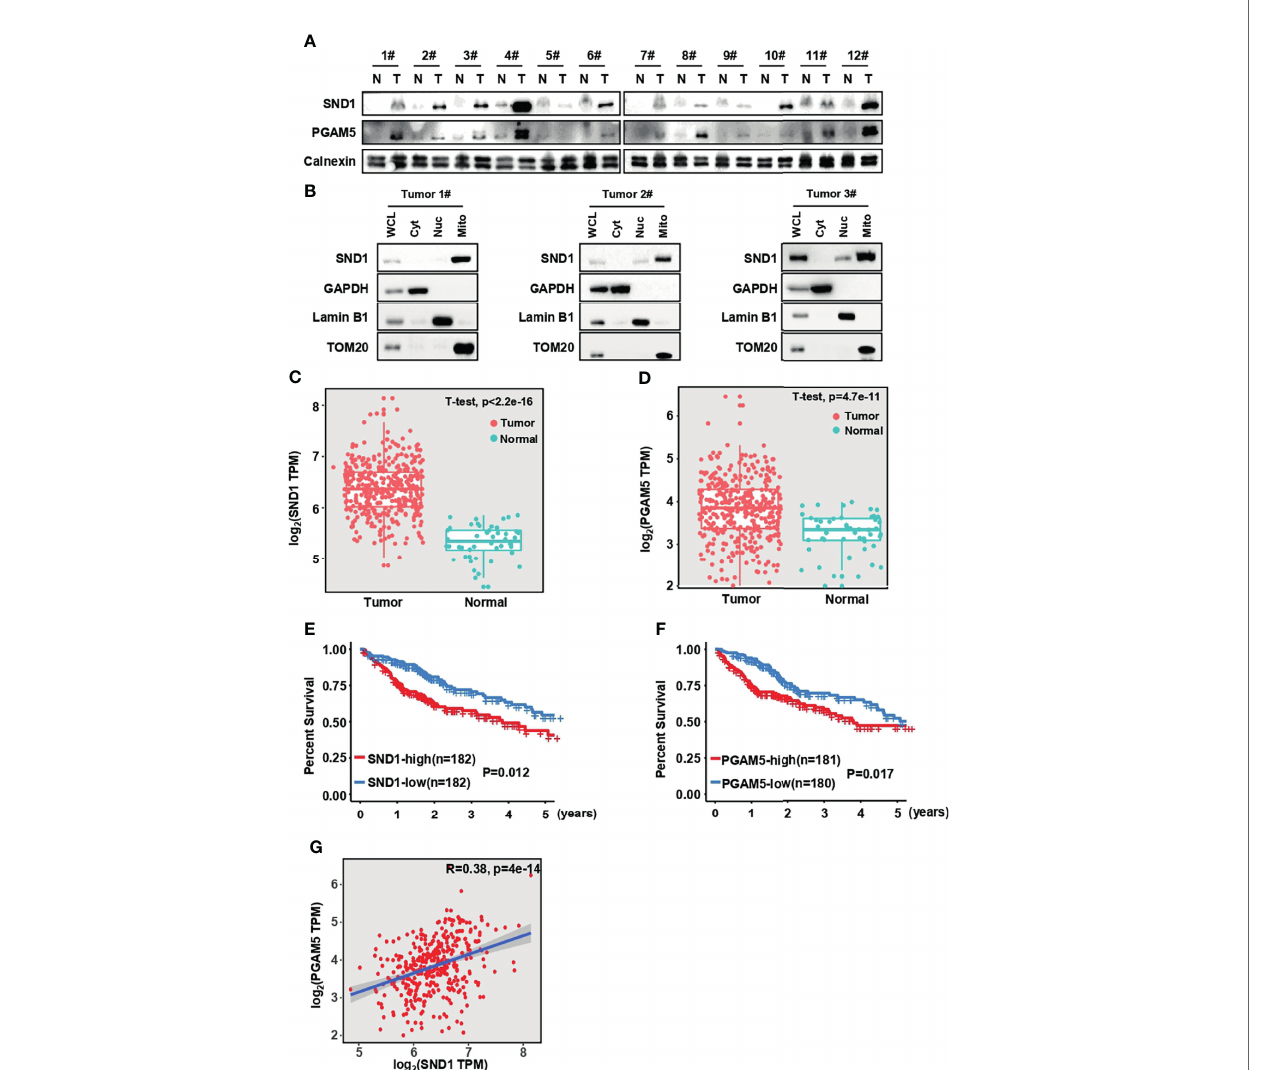
FIGURE 8 | SND1 and PGAM5 are potential prognostic markers for HCC patients. (A) Immunoblotting analysis of SND1 and PGAM5 protein levels in 12 pairs of clinically matched adjacent noncancerous liver tissues (Normal) and human liver cancer tissues (Tumor). Calnexin served as loading control. (B) Immunoblotting analysis of SND1 protein levels in Cyt, Nuc, and Mito components puri fi ed from tumor tissues of HCC patients. GAPDH, Lamin B1, and TOM20 were used as markers of cytosolic, nuclear, and mitochondrial proteins, respectively. (C, D) mRNA levels of SND1 (C) and PGAM5 (D) were determined in adjacent noncancerous liver tissues (Normal) and liver cancer tissues (Tumor) from The Cancer Genome Atlas (TCGA) database (http://gepia.cancer-pku.cn/). (E, F) Kaplan-Meier analysis of overall survival with log-rank tests for low versus high expression of SND1 or PGAM5 genes in HCC patients (http://gepia.cancer-pku.cn/). (G) SND1 is positively correlated with the expression of PGAM5 in liver cancer tissues based on TCGA cohort. The line indicates linear regression, and Spearman ’ s rank correlation coef fi cients (R) and the corresponding p value are